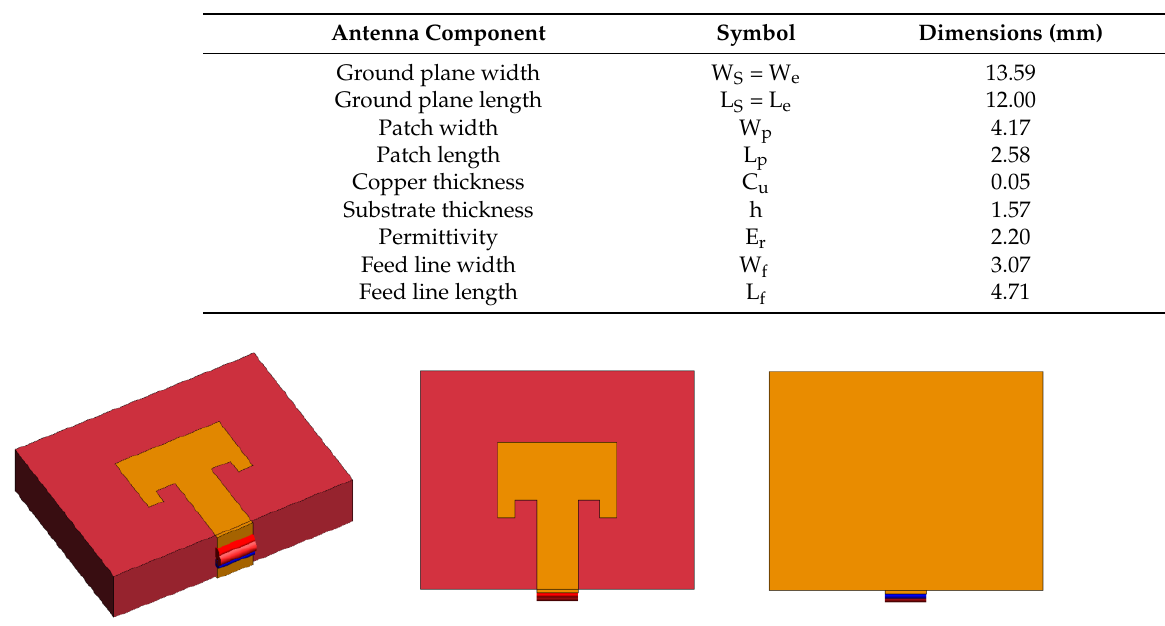
Table 1. Dimensions of the preliminary antenna design.